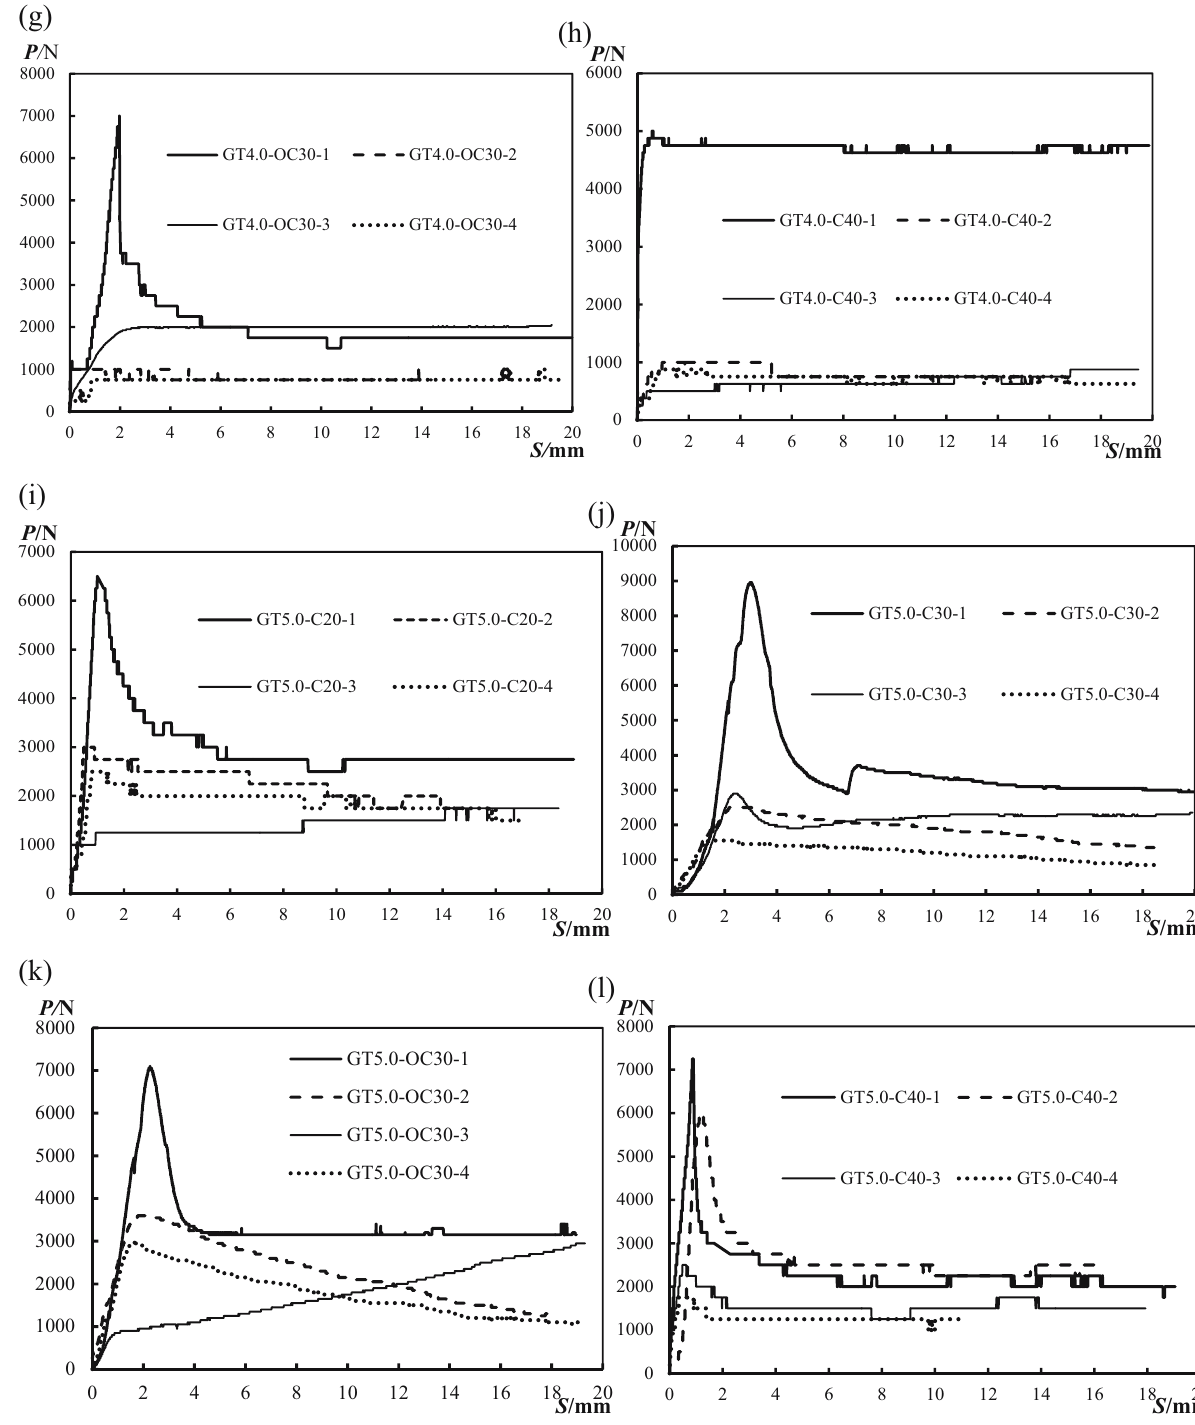
Figure 7: ( a – l ) Axial load – slip curves: ( a ) GT3.5 - C20, ( b ) GT3.5 - C30, ( c ) GT3.5 - OC30, ( d ) GT3.5 - C40, ( e ) GT4.0 - C20, ( f ) GT4.0 - C30, ( g ) GT4.0 - OC30, ( h ) GT4.0 - C40, ( i ) GT5.0 - C20, ( j ) GT5.0 - C30, ( k ) GT5.0 - OC30, ( l ) GT5.0 -